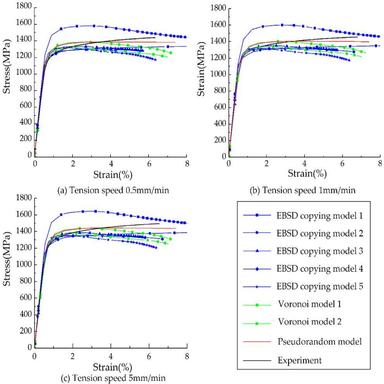
Σ Σ σ − ε curve comparisons of grain scale RVE models.